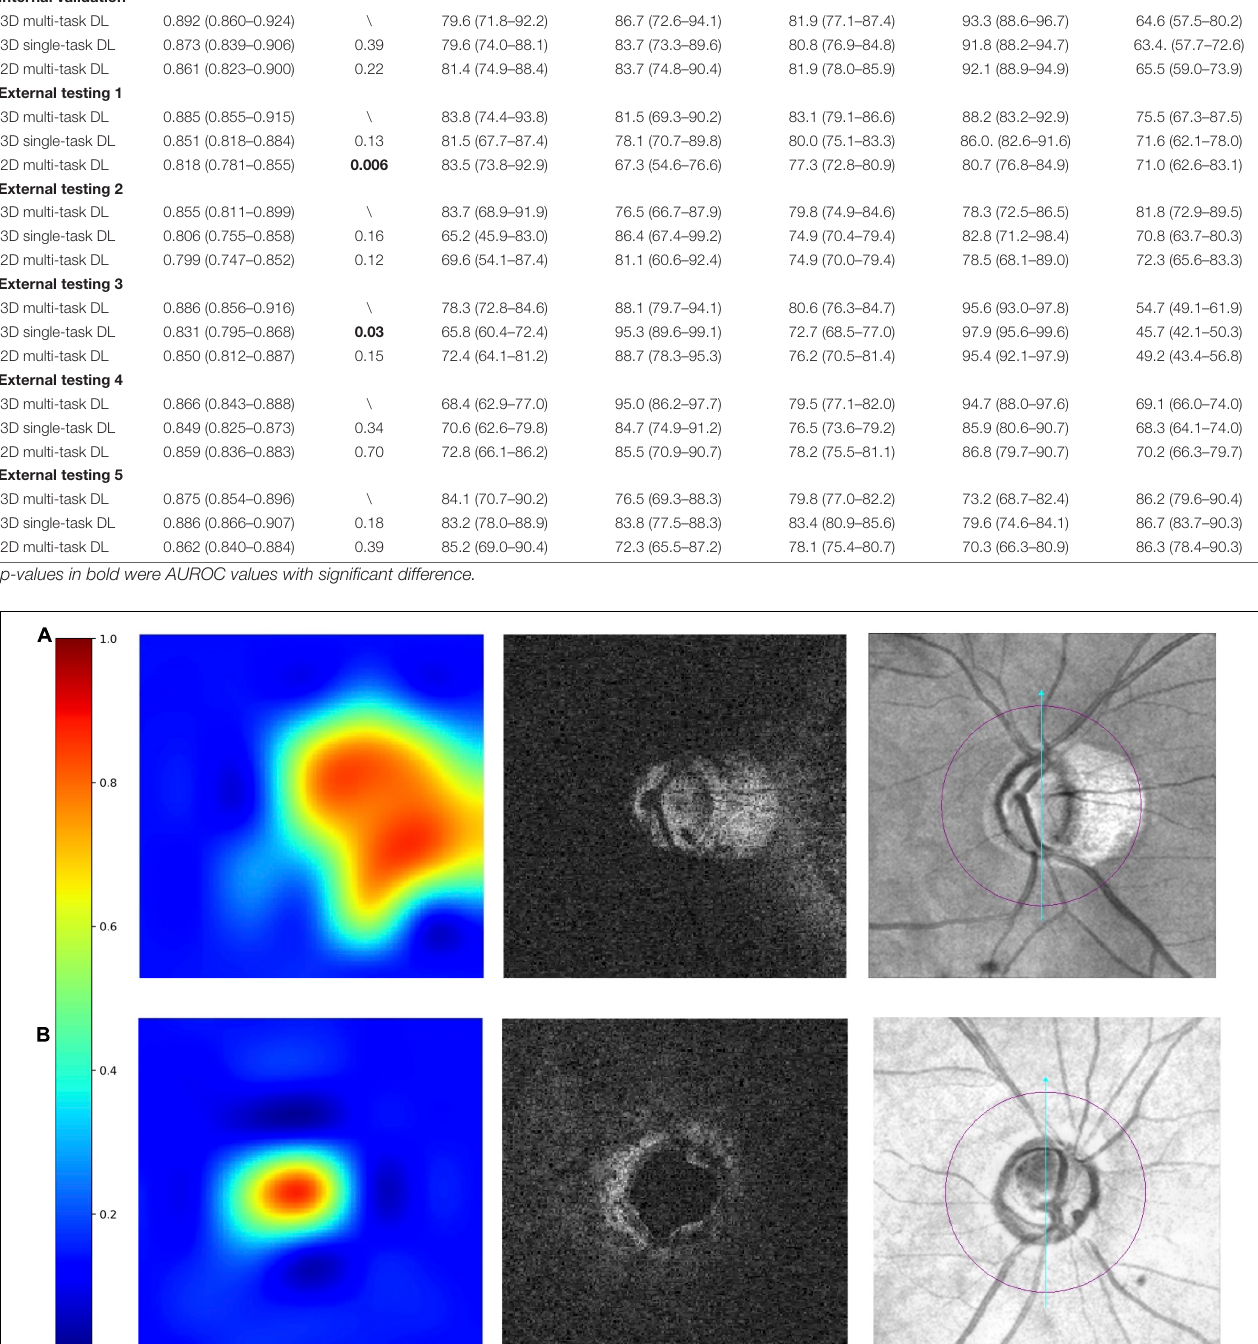
Frontiers in Medicine |